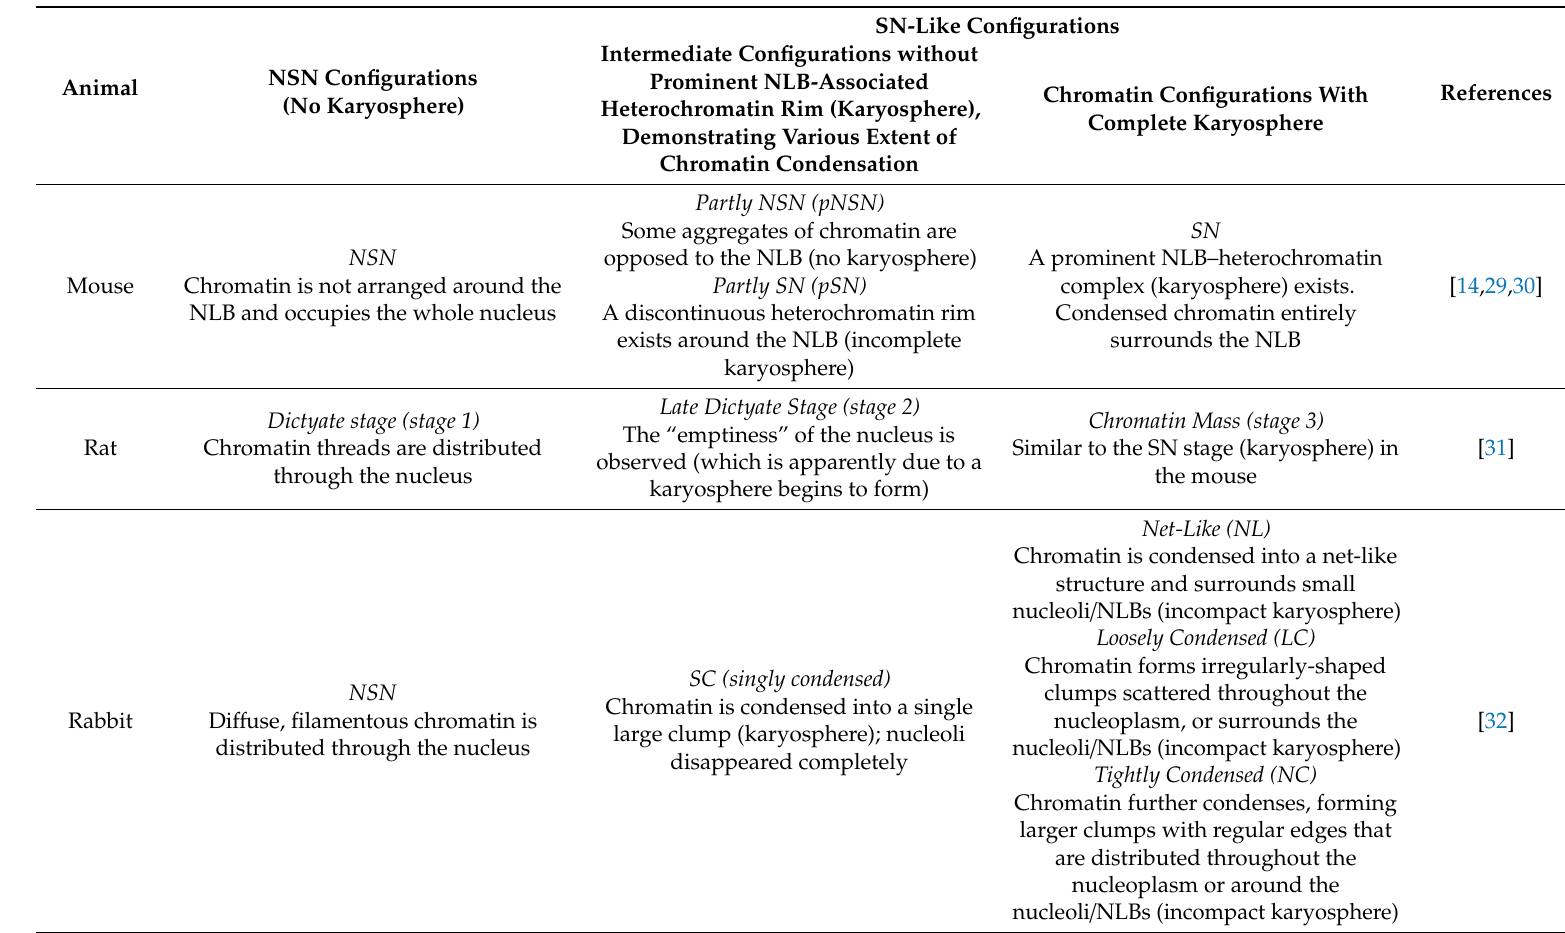
Table 1. Main types of non-surrounded “nucleolus” (NSN)-related and surrounded “nucleolus” (SN)-related configurations of chromatin in mammalian germinal vesicle (GV) oocytes, with reference to the original nomenclature including the